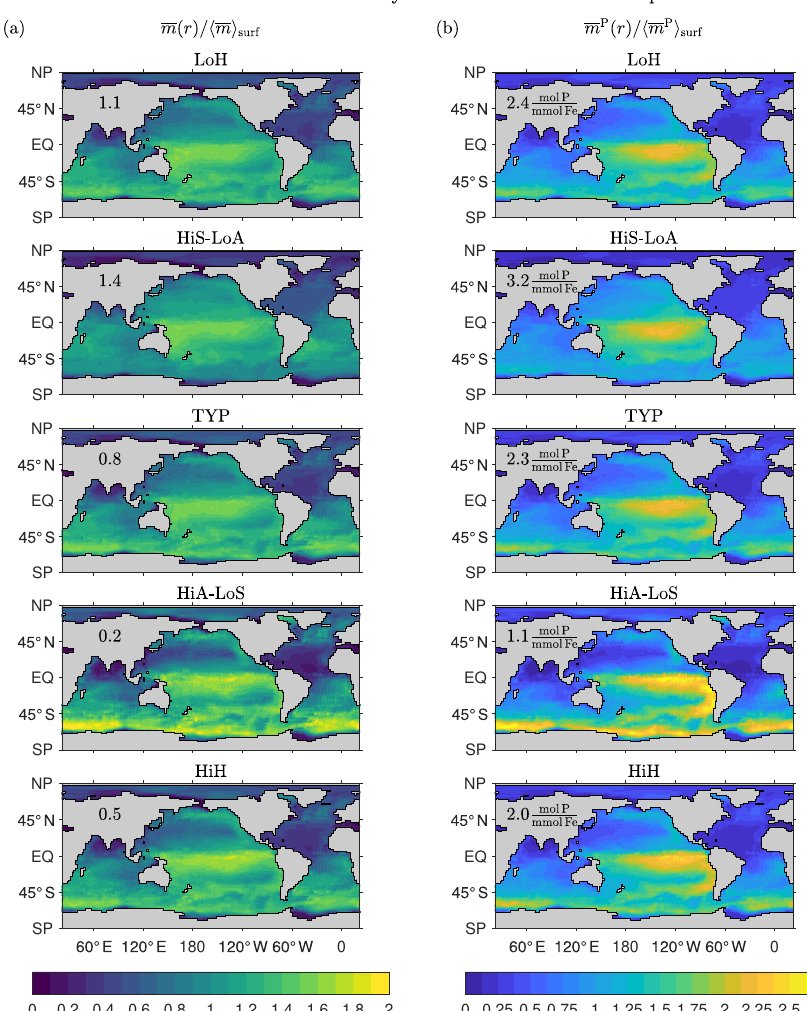
Figure 11. Normalized patterns of our intrinsic fertilization efficiency metrics at the surface. (a) The mean number of iron molecules, m( r ) , that will be regenerated per iron molecule at surface point r during that molecule’s lifetime. (b) The corresponding mean number of phosphorus molecules, m P ( r ) , that will be regenerated. To allow for a meaningful comparison of the patterns of different states, m( r ) and m P ( r ) have been normalized by their global surface averages, (cid:104) m (cid:105) surf and (cid:104) m P (cid:105) surf (values are given in each